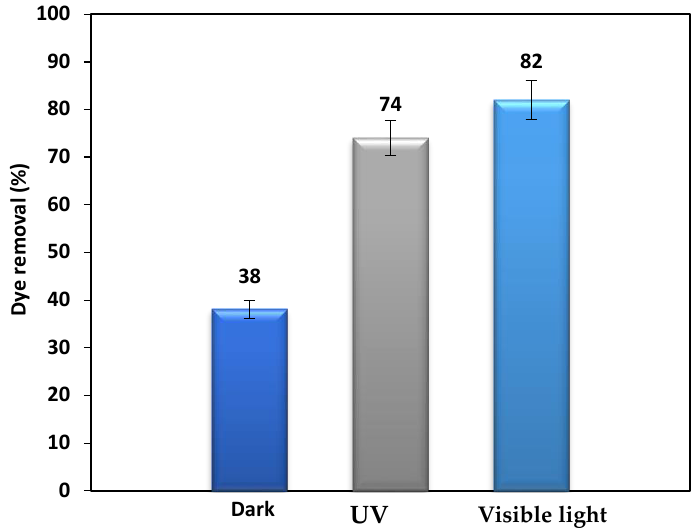
Figure 7. Effect of irradiation type on DR16 removal efficiency.